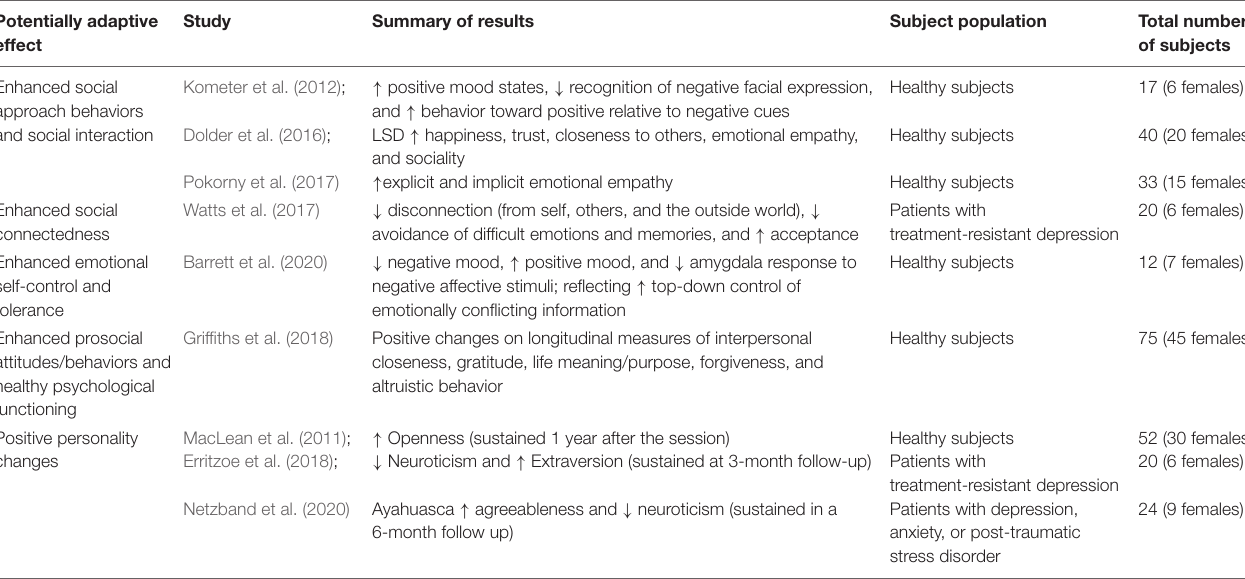
TABLE 2 | Evidence for enhanced social and interpersonal capacities during and after psychedelic